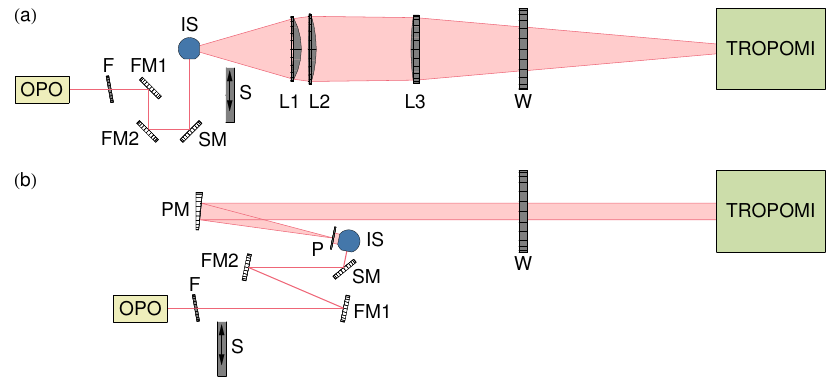
Figure 2. The setup for (a) irradiance measurements and (b) radiance measurements. The elements after the OPO are neutral density filter F; folding mirrors FM1 and FM2; spinning mirror SM; integrating sphere IS; shutter S; lenses L1, L2 and L3; field stop P; parabolic mirror PM; and window W of the vacuum chamber containing TROPOMI. The light enters (a) the Sun port or (b) the Earth port of the